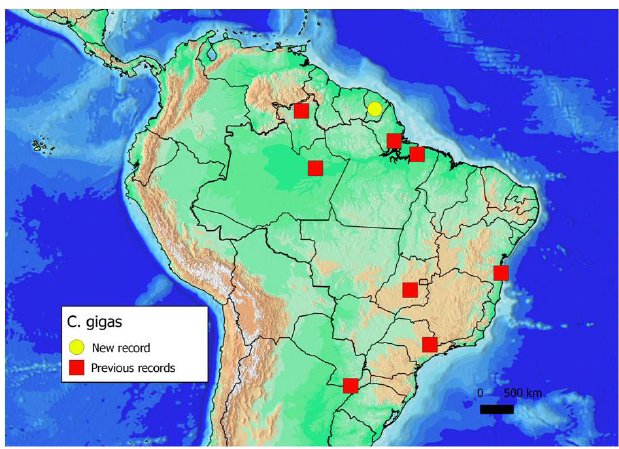
Fig 2 . Distribution map of Centromyrmex gigas in the Neotropics based on literature records and the present